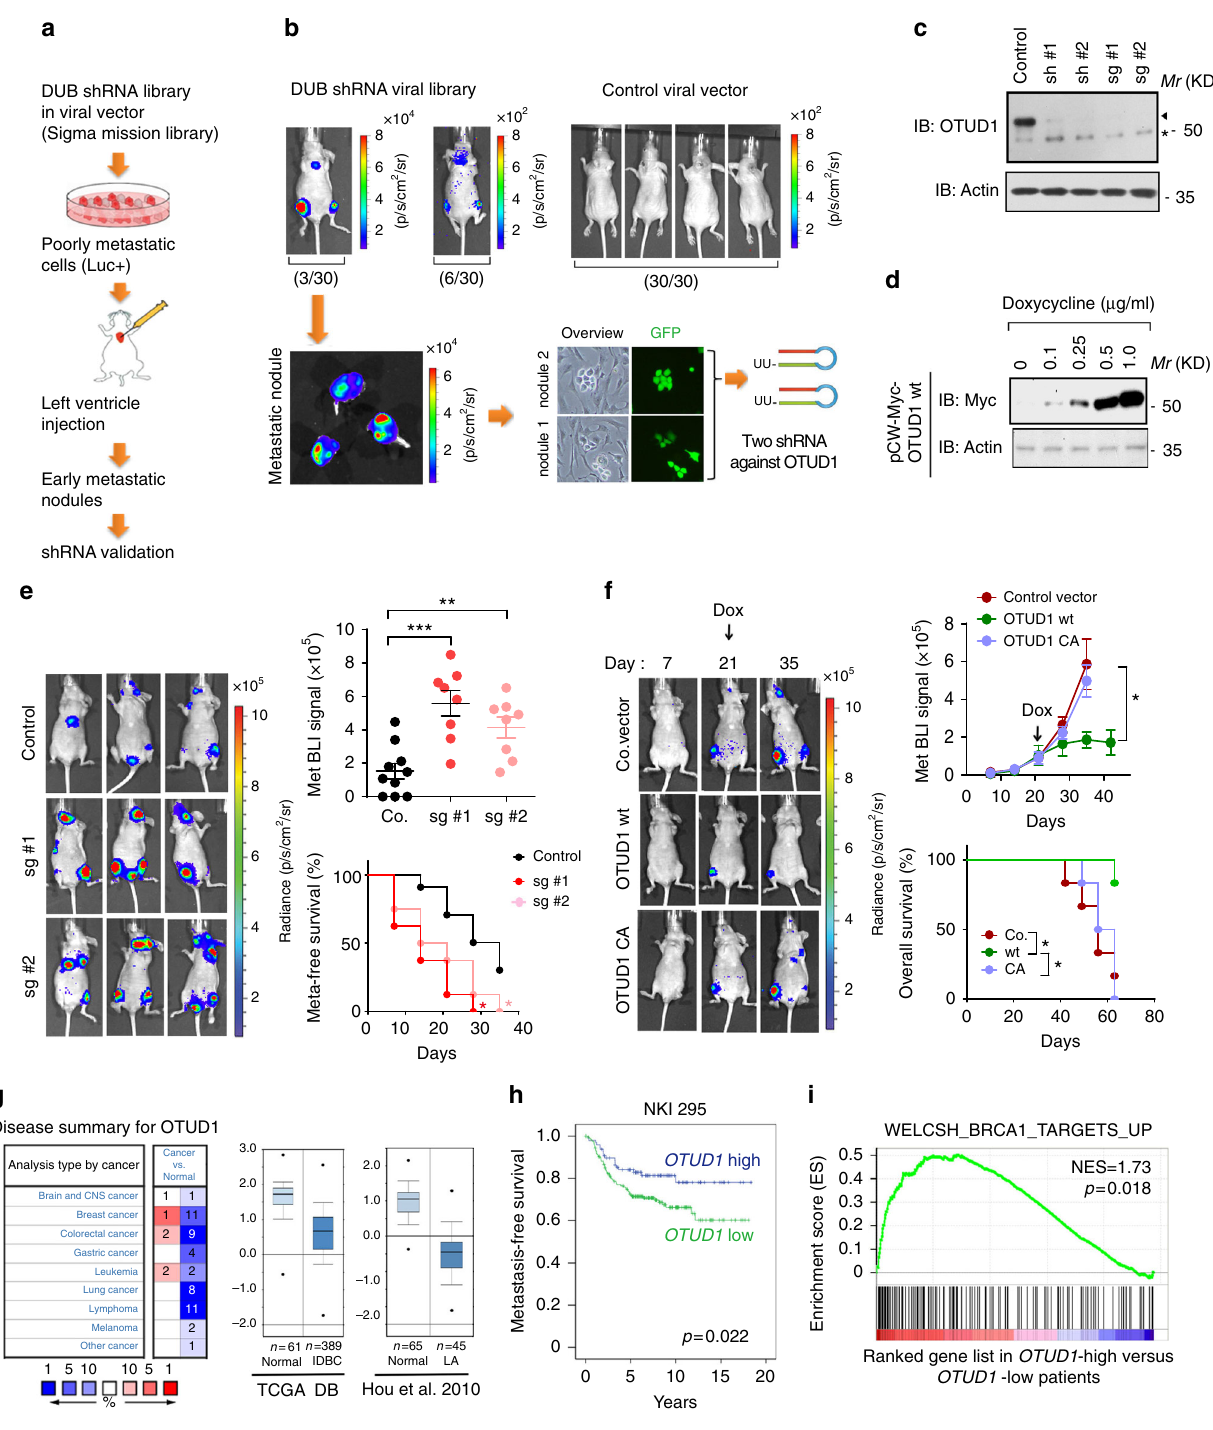
Brain and CNS cancer Breast cancer Colorectal cancer Gastric cancer Leukemia Lung cancer Lymphoma Melanoma Other